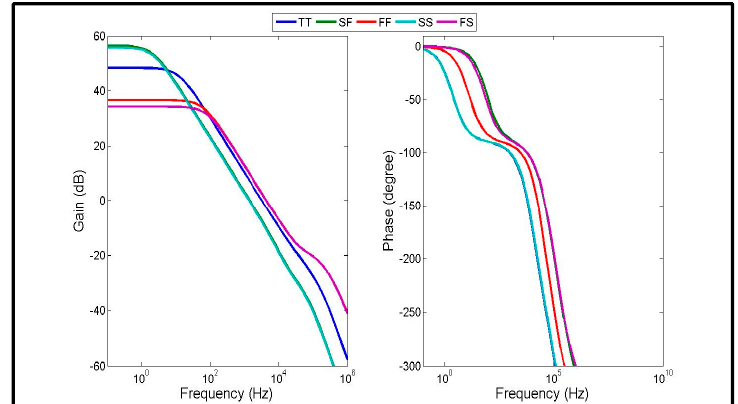
Figure 9. Process corner effects on the ac gain and phase response.